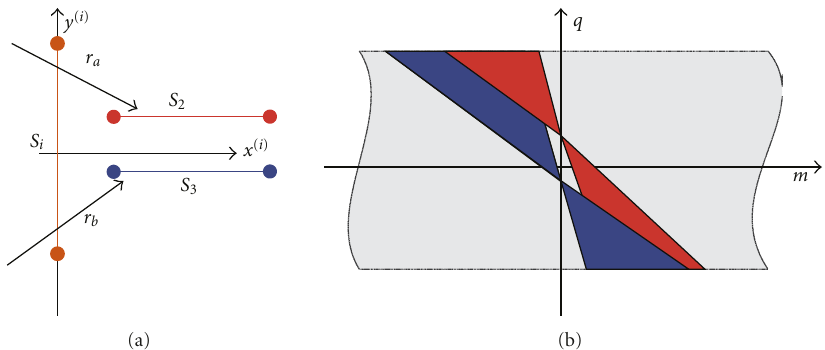
Figure 2: Ambiguity in the occlusion between two nonoriented reflectors s 2 and s 3 . For some rays (e.g., r a ) s 2 occludes s 3 . For other rays (e.g., r b ) s 3 occludes s 2 .